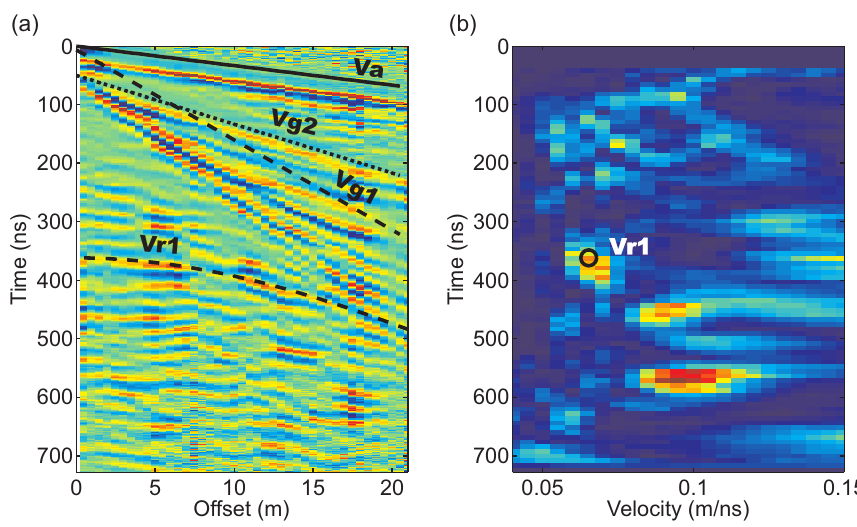
Fig. 5. (a) GPR data from CMP1, which was recorded using 50MHz antennas (location shown in Fig. 3a). Solid line shows the linear moveout of the picked airwave phase (Va); dashed lines show the linear moveout of a slow groundwave phase attributed to a thin soil layer (Vg1), and the normal moveout of a subsurface reflection (Vr1); dotted line shows the linear moveout of a second fast groundwave phase attributed to a substrate of bedrock underlying the meadow (Vg2). (b) Corresponding semblance plot for which warmer colours represent higher values. Circle defines the normal moveout velocity calculated for picked reflection Vr1 shown in